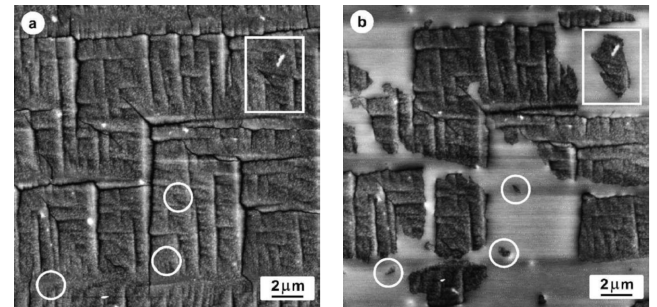
Figure 27. AFM height images of the iPBu flat-on crystals scanned at ( a ) room temperature and ( b ) at 124 °C. The used sample was initially crystallized at 100 °C for 24 h and then aged at room temperature for five days. The white markers indicate the same area of the sample. Reproduced with permission from Ref. [150], copyright 2004 Elsevier Ltd. All rights reserved.